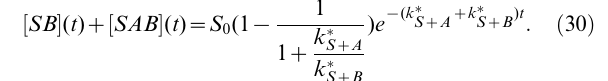
Figure 2. Model in which protein A increases the association rate of protein B . k (cid:3) ~ 0 : 1 k (cid:3) . Solid lines are for protein B , the dotted line is for protein A , and the dashed lines are used for estimating the to top curve. A) k (cid:3) S z B SA z B order of magnitude of the rate constants from the curves, giving k (cid:3) 1 k (cid:3) & 0 : 097 for the slowest curve. Depending on the parameters the curves show an increasing slope at the beginning. B) same & SA z B 36 : 8 { 26 : 5 ~ 0 . The curves always show an increasing slope at the beginning, which helps distinguishing this case from the one parameters as in A) except k (cid:3) S z B shown in Figure 2A. Additionally, for large values of A 0 the recruitment curves of B resemble the recruitment curve of A , which is not the case if w 0 . k (cid:3) S z B